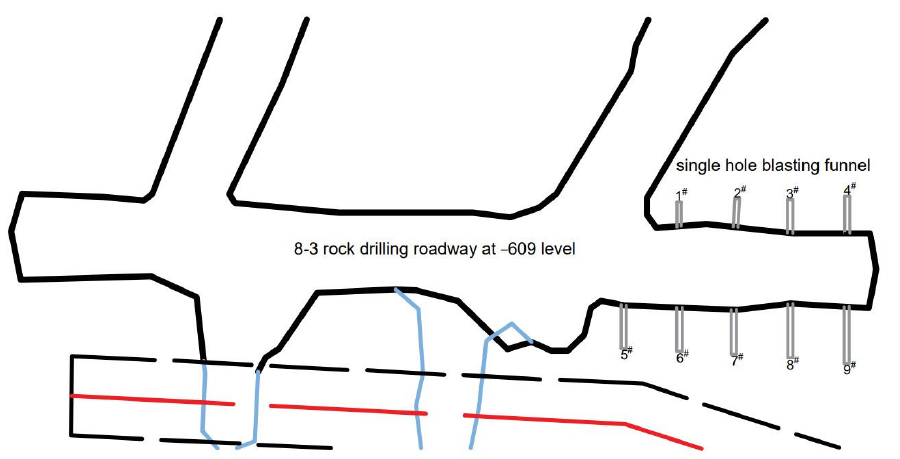
Figure 2. Schematic diagram of plane layout of blast holes in funnel test of single-hole blasting. (In the figure, ‘ # ’ is for the convenience of numbering the holes, 1 # represents hole number one, and so on)